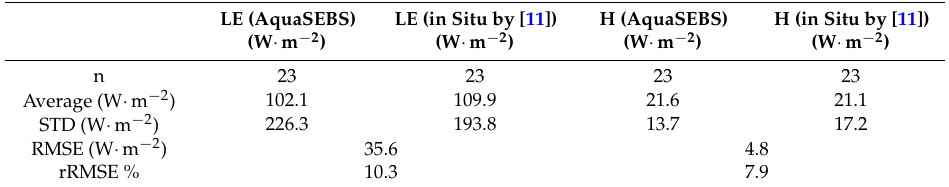
Figure 5. Comparison between the latent heat calculated by AquaSEBS and the in situ data measured over Lake Tana [11]. Table 3. Comparison of the AquaSEBS results and heat fluxes calculated from field measurements over Lake Tana by [11] (W·m − 2 ).